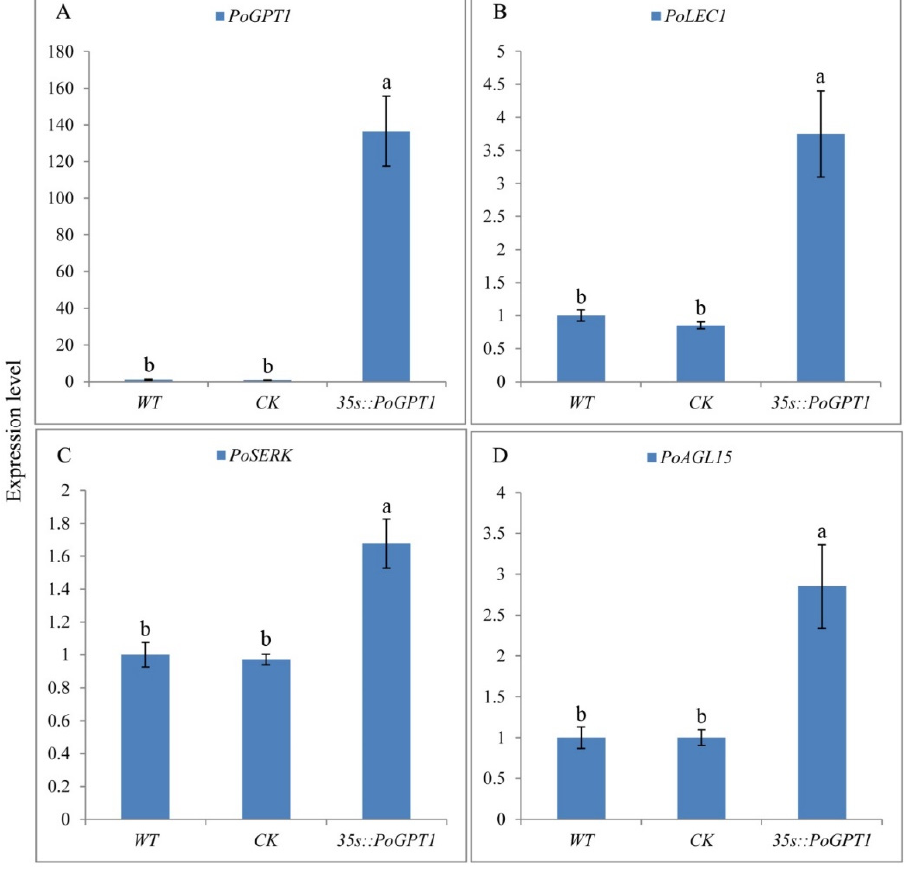
Figure 5. RT-qPCR positive identification and expression level of embryogenesis-related genes in PoGPT1- overexpressing transgenic calli of tree peony (( A ), Expression level of PoGPT1 ; ( B ), Expression level of PoLEC1 ; ( C ), Expression level of PoSERK ; ( D ), Expression level of PoAGL15 ). Vertical bars indicate standard error ( n = 3). Different letters indicate significant differences using the Duncan’s Multiple Range Test ( p ≤ 0.05).